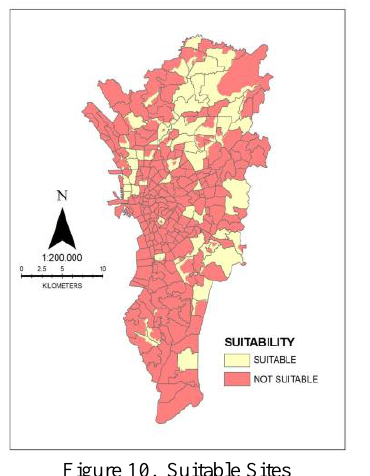
Figure 10. Suitable Sites